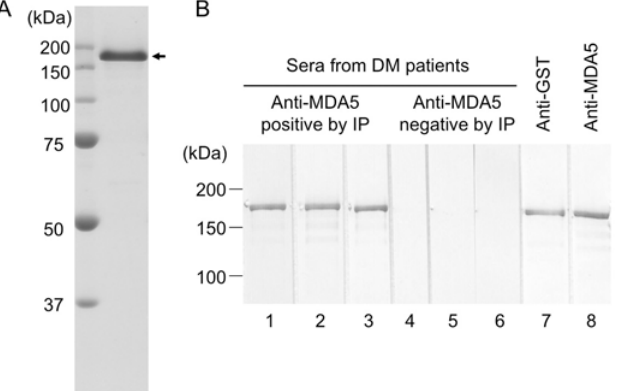
Fig 1. Purity and antigenicity of recombinant GST-MDA5 protein. A. Purified recombinant GST-MDA5 fusion protein (2 μ g) was subjected to sodium dodecyl sulfate-12.5% polyacrylamide gel electrophoresis,